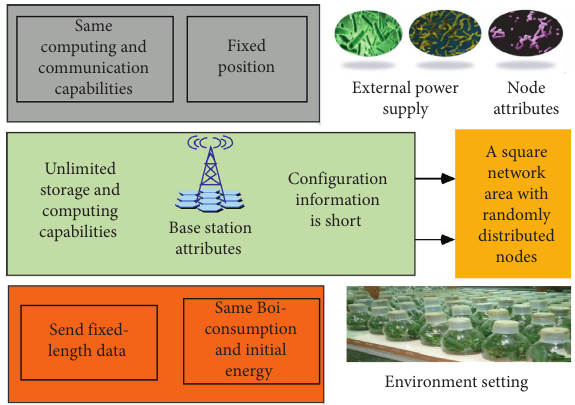
Figure 4: Modular composition of the data aggregation